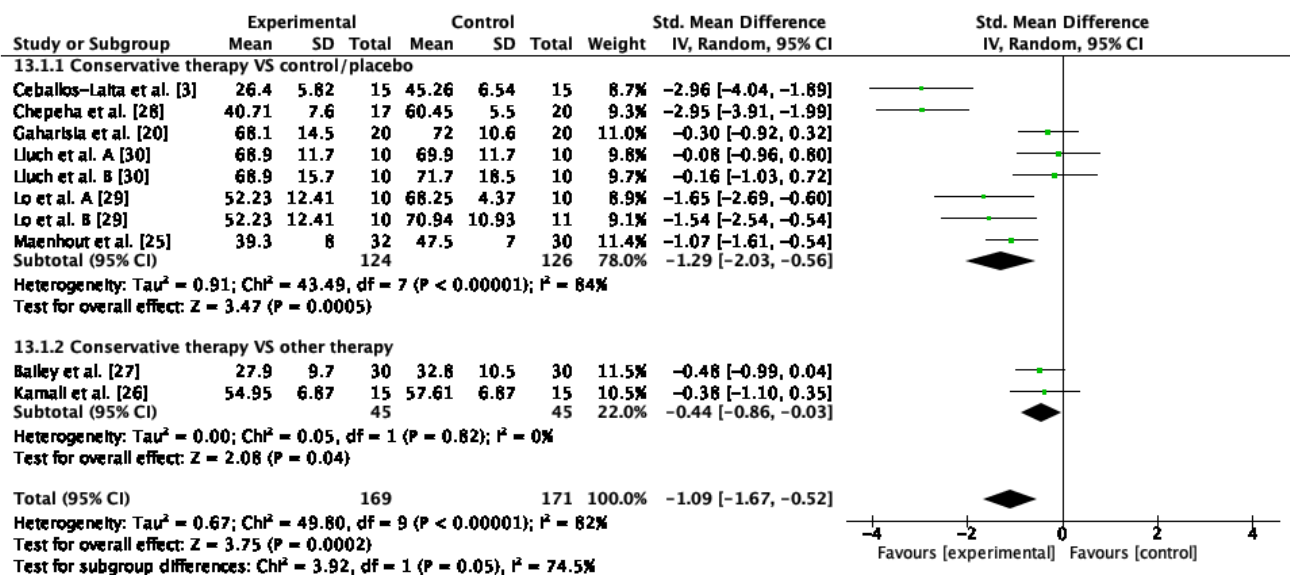
Figure 3. Forest plot of internal rotation ROM for conservative therapy versus control/sham and combination of conservative therapies versus conventional therapy in isolation. Lluch et al. A. compared manual therapy versus control intervention. Lluch et al. B compared the manual contact versus control intervention. Lo et al. A compared KT versus control intervention. Lo et al. B compared stretching versus control intervention.